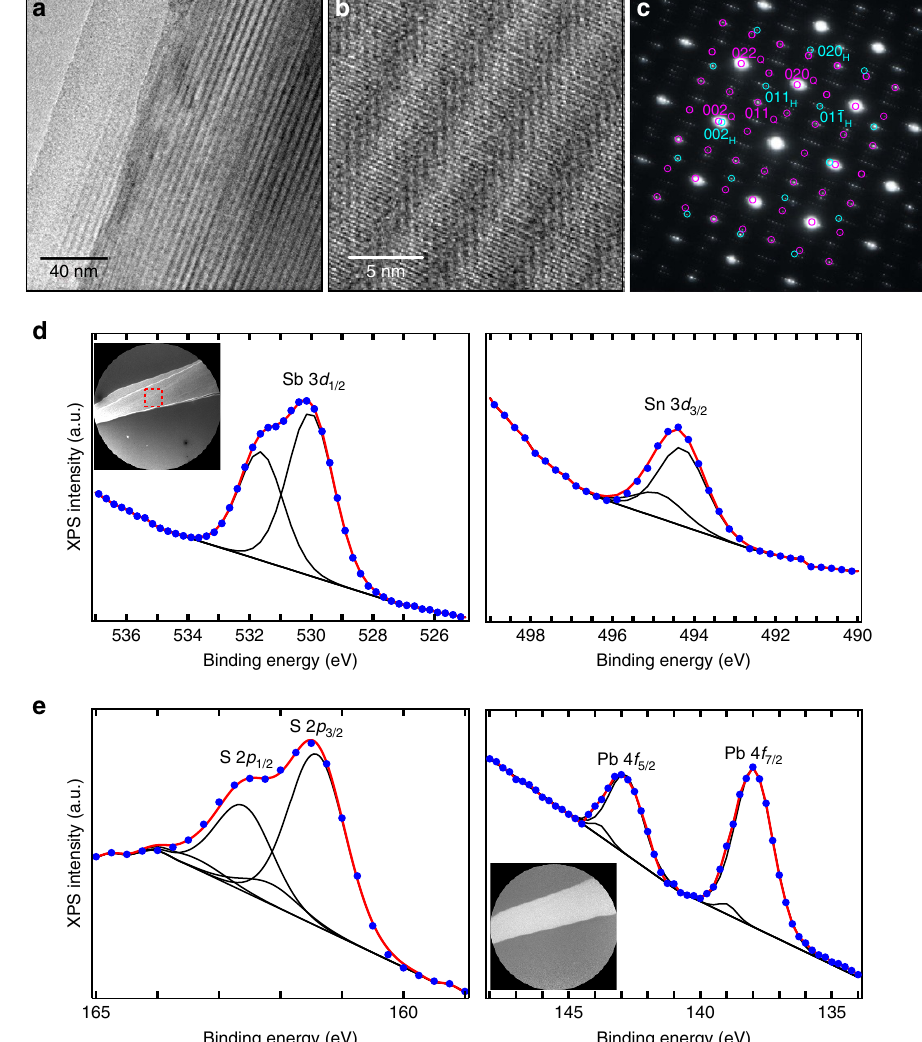
Figure 2 | Characterization of mechanically exfoliated franckeite flakes. ( a ) HRTEM micrograph of a franckeite sheet exhibiting the characteristic fringes of franckeite due to the corrugation induced by the misfit between Q and H layers. The scale bar is 40nm. ( b ) Representative atomic scale HRTEM of an ultrathin franckeite layer. The scale bar is 5nm. ( c ) SAED diagram consistent with a misfit layer compound made of PbS and SnS 2 layers: Q (purple) and H sublattices (light blue) lead to the most intense reflections on which superlattice rows of weak intensity are centred. The diagram has been indexed using tetragonal and orthohexagonal vectors for the Q and H phases respectively, according to the orientation and nomenclature defined in ref. 23. ( d ) Sb 3 d 3/2 and Sn 3 d 3/2 XPS spectrum acquired with photon energy h n ¼ 600eV. Inset: LEEM image (the field of view is 50 m m and the electron energy is 0.12eV), the red square indicates the region of integration where the XPS spectra has been acquired. ( e ) S 2 p 1/2 and 2 p 3/2 and Pb 4 f 5/2 and 4 f 7/2 XPS spectrum acquired with photon energy h n ¼ 230eV. Inset: XPEEM image at Pb 4 f 7/2 core level (the field of view is 50 m m and the photon energy is 230eV). The strong background in the XPS spectra is due to the tail of secondary electrons